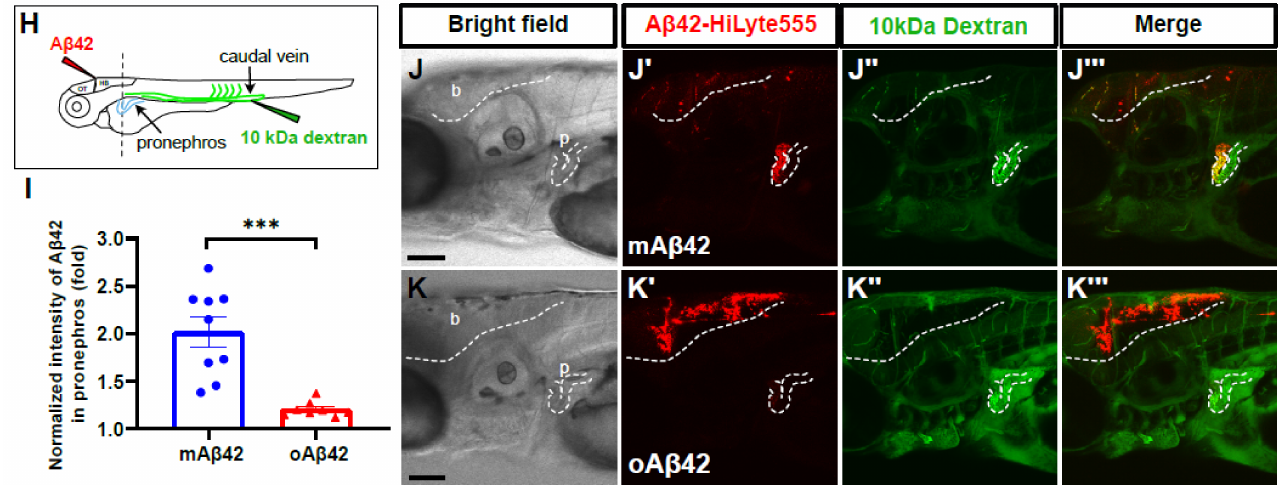
Figure 2. Cleared mA β 42 accumulates in the pronephros via blood flow. ( A , B ) mA β 42-injected larvae after propranolol (100 µ M) treatment. The mA β 42 intensity in the pronephros of propranolol-treated larvae (white dotted lines) decreased ( B ) compared to control ( A ). ( C , D ) mA β 42-injected larvae after control morphants ( C ) and 200 µ M tnnt2a morphants ( D ). ( E ) Quantification of heartbeats upon propranolol treatment. n = 9 for control group, n = 10 for propranolol. ( F ) Quantification of the mA β 42 intensity in the pronephros after propranolol treatment. n = 8 per group. ( G ) Quantification of the mA β 42 intensity in the pronephros of control and tnnt2a morphants. Statistical significance was determined by two tailed unpaired t -test. Data are presented as mean ± SEM. n = 9 per group. Data are representative of at least three independent experiments. ( H ) A schematic diagram of experimental setting of A β and tracer injection. mA β 42 or oA β 42 (HiLyte) was injected into ventricle and 10 kDa Dextran was injected into caudal vein. ( I ) Quantification of the A β 42 fluorescence intensity in the pronephros normalized by background fluorescence. n = 9 for mA β 42, n = 8 for oA β 42. Data are representative of at least three independent experiments. ( J – K (cid:48)(cid:48)(cid:48) ) Confocal fluorescence images showing the brain and pronephros of zebrafish with lateral view after mA β 42 ( J ) or oA β 42 ( K ) injection at 3 dpf. Red fluorescence indicates A β 42-HiLyte Fluor and green fluorescence show 10 kDa dextran tracer injected into caudal vein. ( J (cid:48) ) Ventricle-injected mA β 42 was seen in the pronephros region (white dotted lines and depicted as p). ( K (cid:48) ) Ventricle-injected oA β 42 was seen only in the brain region (b), but not detected in the pronephros. Caudal vein-injected dextran accumulated in the pronephros of both mA β 42 and oA β 42-injected larvae ( J (cid:48)(cid:48) , K (cid:48)(cid:48) ). ( J (cid:48)(cid:48)(cid:48) , K (cid:48)(cid:48)(cid:48) ) show merged images. b, brain; MO, morpholino; p, pronephros; Scale bars = 100 µ m. ** p < 0.001; *** p < 0.0005; **** p <